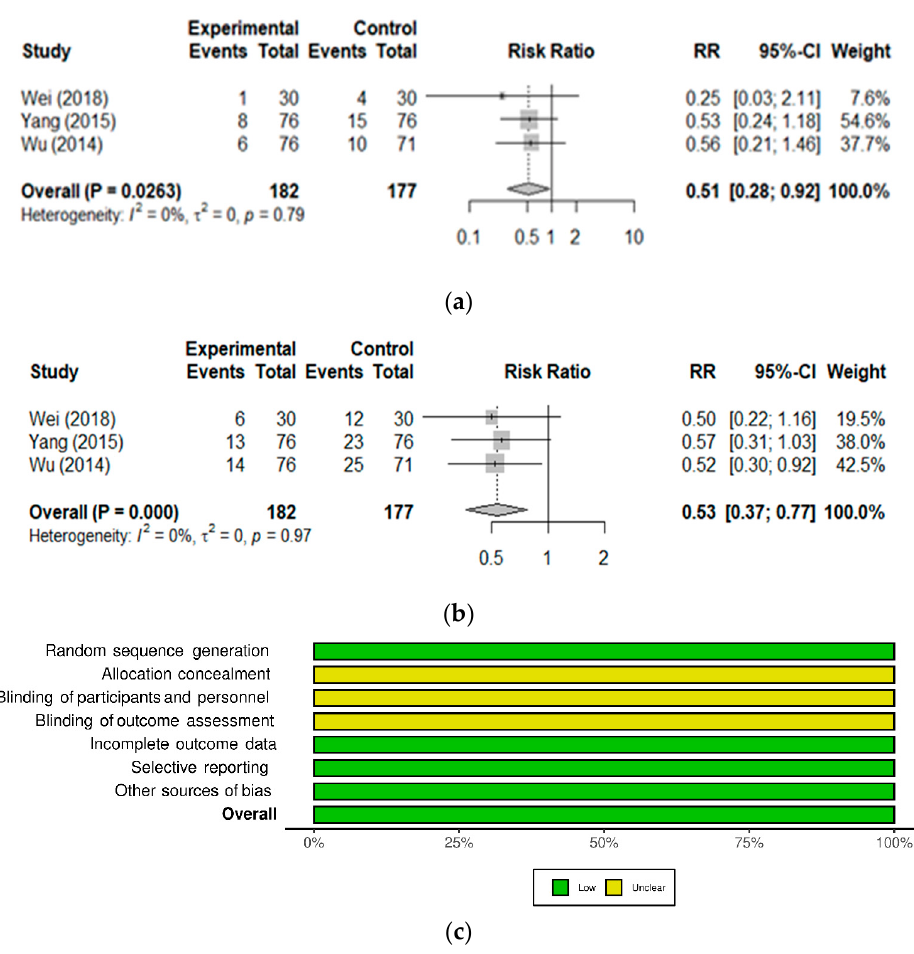
Figure 4. The probiotic reduced the relative risk of unresolved anemia and side effects in children with nutritional iron deficiency anemia receiving iron supplementation. Forest plot of studies on IDA treatment efficacy and occurrence of side effects. The 3 studies included in these meta-analyses are detailed in Table 4. (References: Wei, 2018 [35], Yang, 2015 [37], Wu, 2014 [36]). ( a ) Events refers to the number of cases categorized as inefficient (negative outcome of treatment); Total refers to the number of participants in the Experimental (Probiotic) and Control groups. ( b ) Events refers to the number of cases experiencing iron supplementation-related side effects; Total refers to the number of participants in the Experimental (Probiotic) and Control groups. ( c ) Mosaic plot showing the summary of the risk of bias analysis of studies included in the meta-analysis.